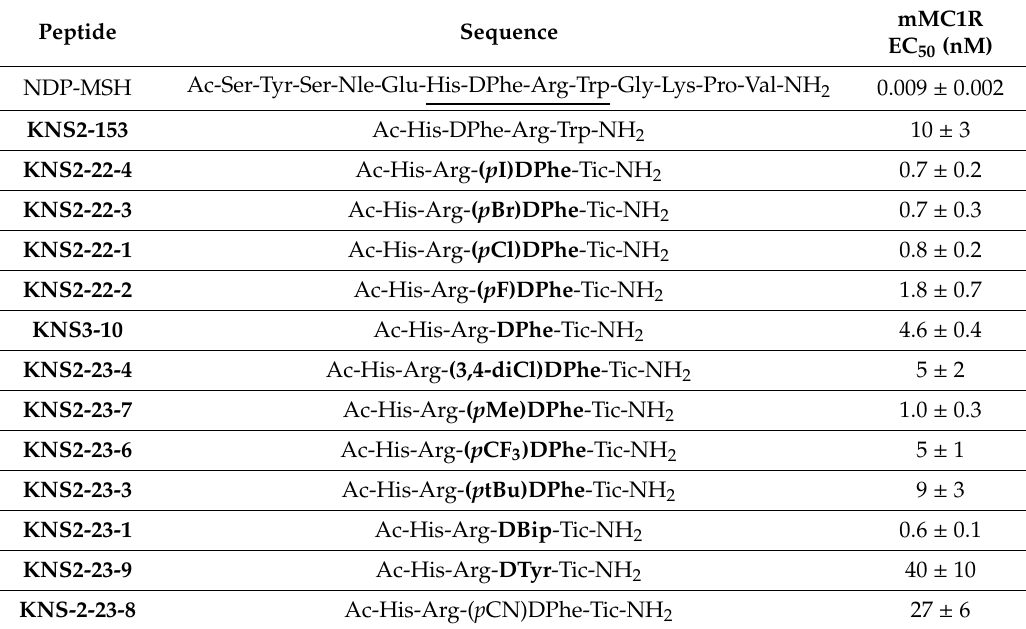
Table 2. Tetrapeptide pharmacology at the mouse melanocortin-1 receptor using the AlphaScreen cyclic adenosine monophosphate (cAMP) assay a